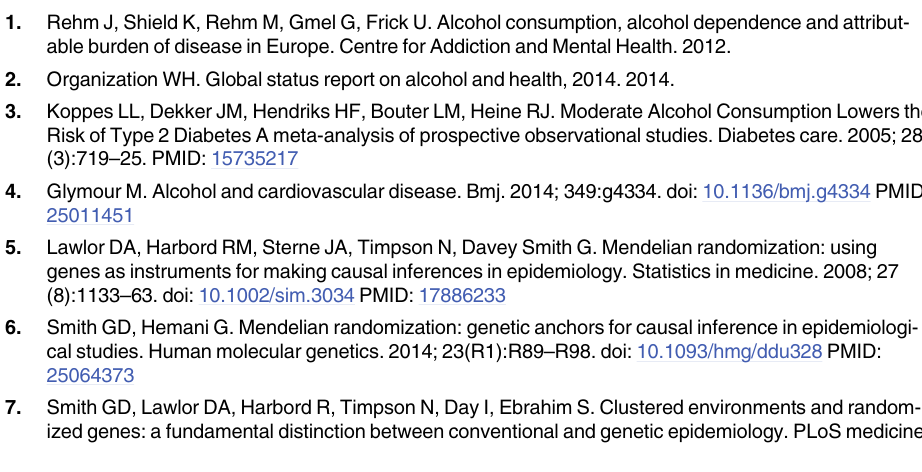
S7 Table. Sensitivity analysis for repeated measures analysis in ALSPAC